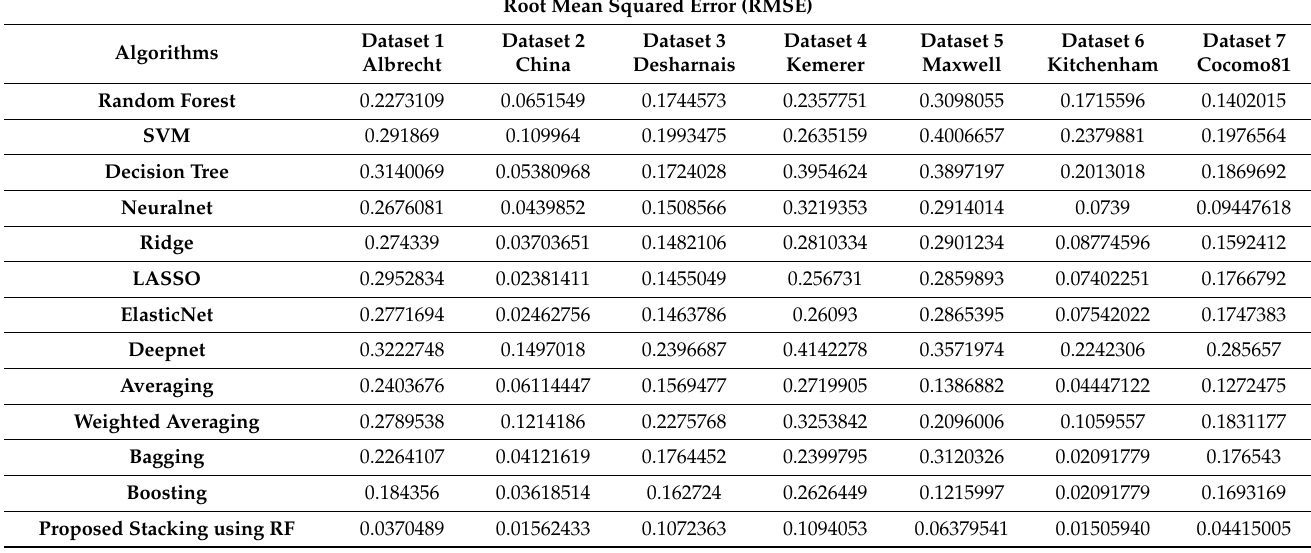
Table 5. Base learners and ensemble techniques vs. RMSE of 7 datasets. Root Mean Squared Error